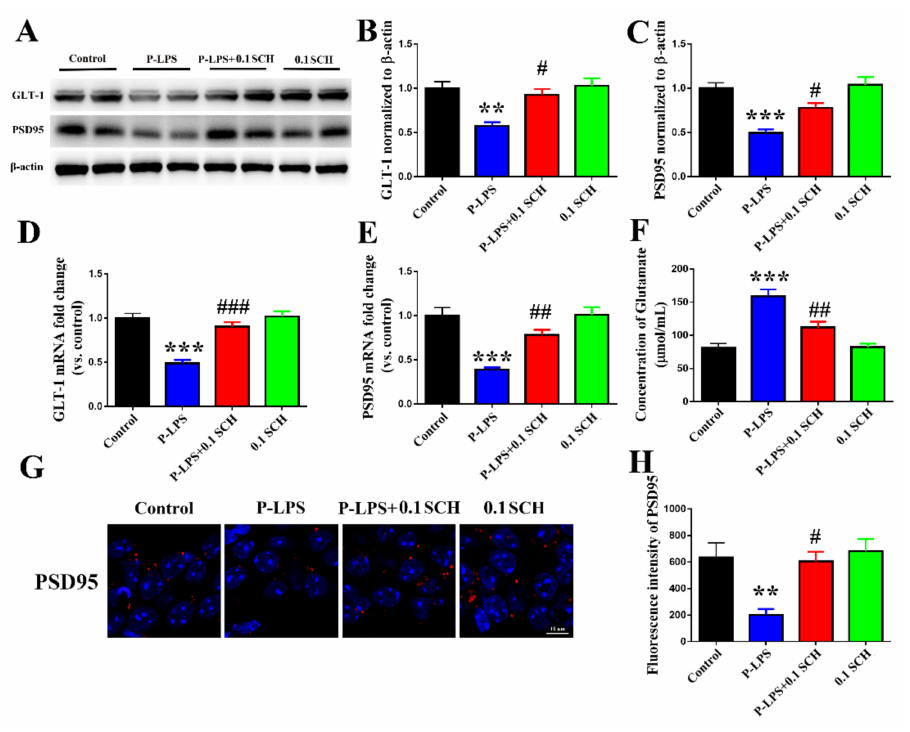
Figure 6. A 2A R antagonist alleviates P. gingivalis LPS-induced GLT-1 and PSD95 decline in the hippocampus of mice. The protein levels of GLT-1 ( A , B ) and PSD95 ( A , C , G , H ) in the hippocampus of mice were detected by Western blot and immunofluorescence, while the mRNA of GLT-1 ( D ) and PSD95 ( E ) were detected by qRT-PCR. The concentration of glutamate ( F ) was detected by colorimetric enzyme method. All data are expressed as the mean ± SEM ( n = 6 per group). ** p < 0.01 and *** p < 0.001 vs. the control group; # p < 0.05, ## p < 0.01 and ### p < 0.001 vs. the P-LPS